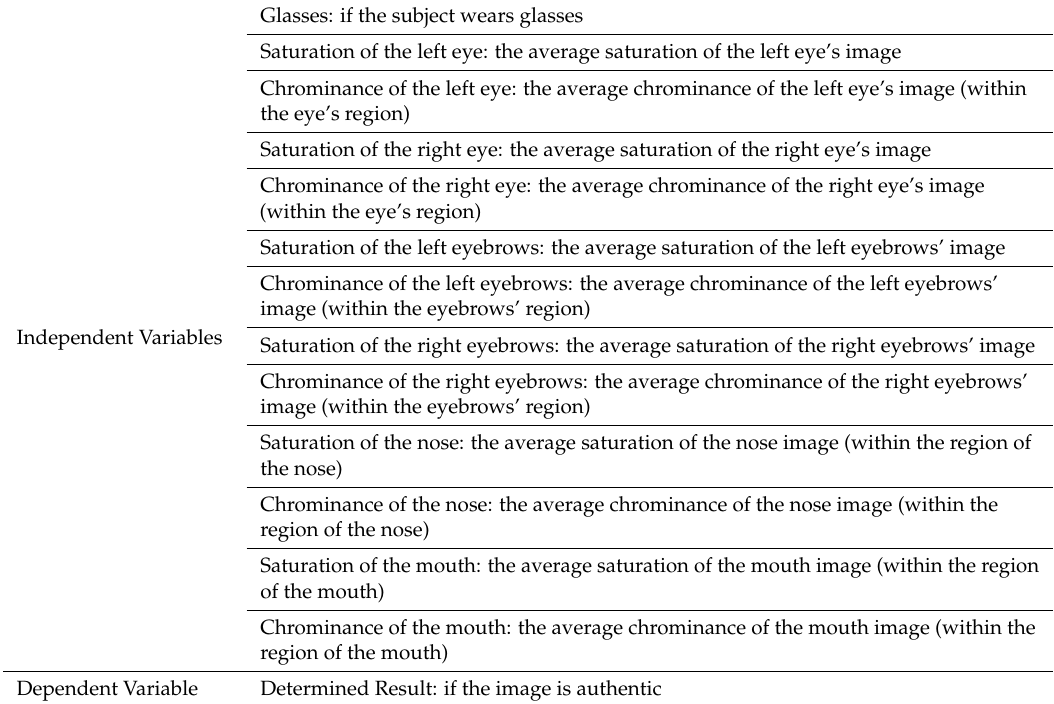
Table 1. The control variables description for training